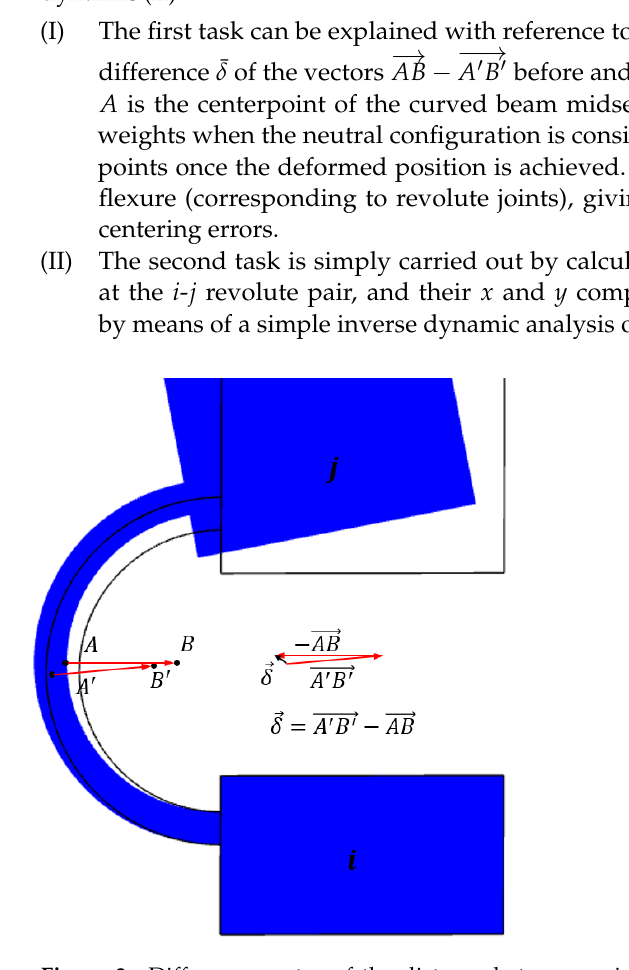
Figure 3. Difference vector of the distance between points A and B of a generic flexure hinge calculated, respectively, for the neutral and deformed